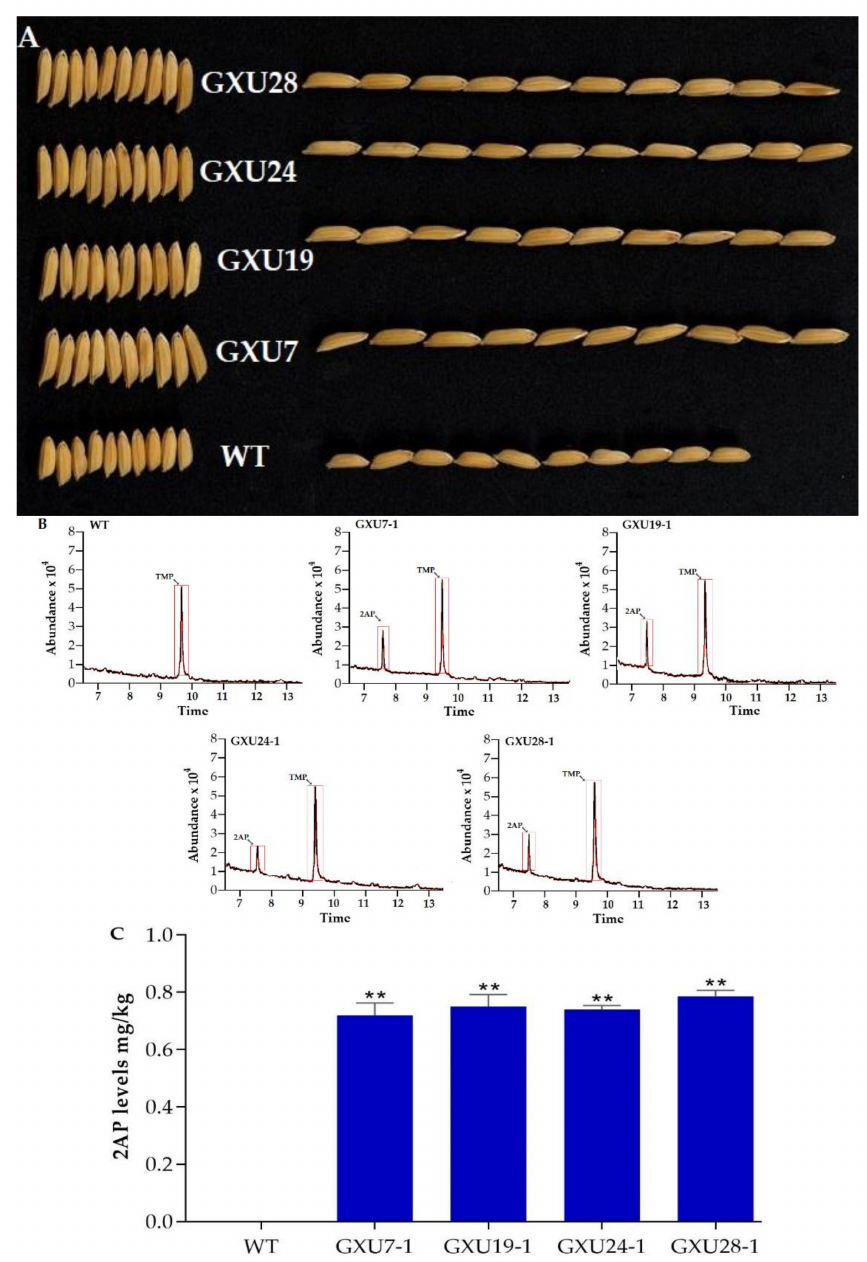
Figure 3. Grain phenotype and the 2-acetyl-1-pyrroline (2AP) levels of homozygous mutants and wild-type (WT) grains. ( A ) Grain phenotype of WT and homozygous mutant lines (GXU7-1, GXU19-1, GXU24-1, and GXU27-1). ( B ) The total ion chromatograms (TIC) of 2AP and TMP (as internal standard) in the T 1 homozygous mutant lines and WT. ( C ) 2AP levels of the mutants and WT. Values are means ± SD, n = 5, p ≤ 0.01, student’s t -test. ** indicates significant di ff